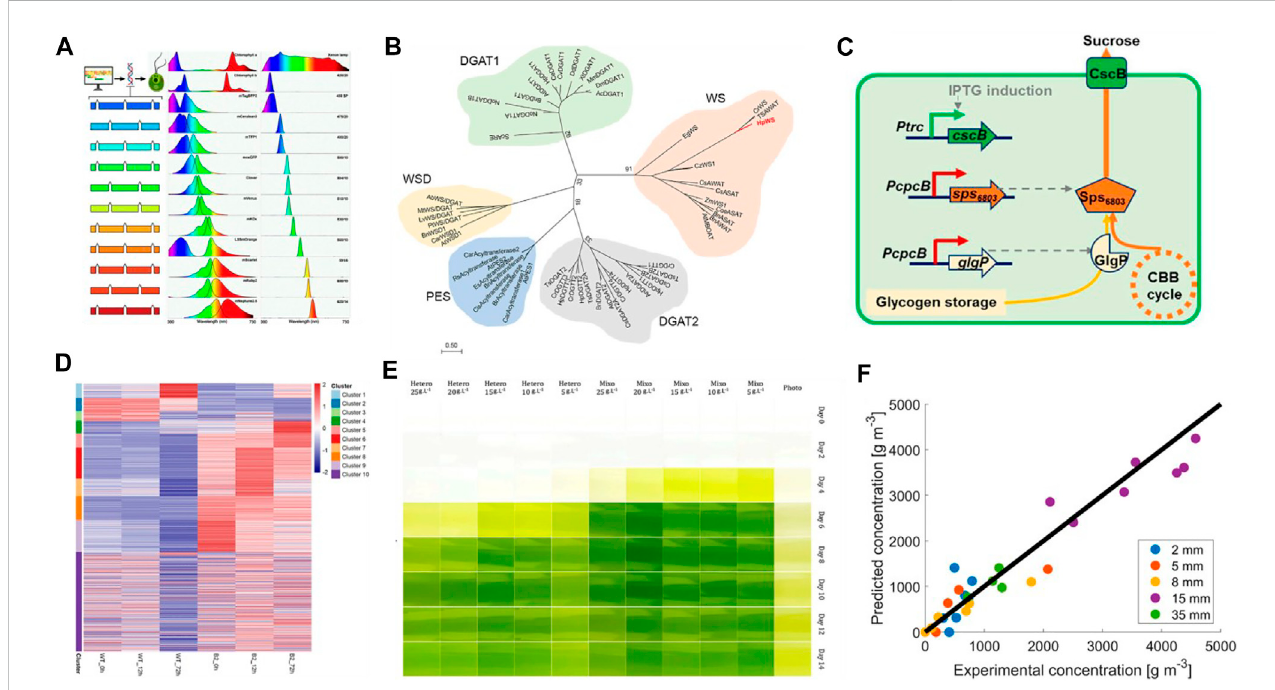
FIGURE 1 Representative articles in this Research Topic. (A) Technical advances for transformant selection in C. reinhardtii (Gutiérrez et al.). (B) Novel bifunctional wax ester synthase (HpWS), identi fi ed in H. pluvialis , andheterogeneous expression of HpWS in C. reinhardtii for triacylglycerol accumulation (Ma et al.). (C) Overexpression of GlgP (glycogen phosphorylase) increased sucrose production in S. elongatus (Dan et al.). (D) Proteomic analysis of dark- adapted E.gracilis andthebleachedmutantagainstlightstimuli(Chenetal.) (E)